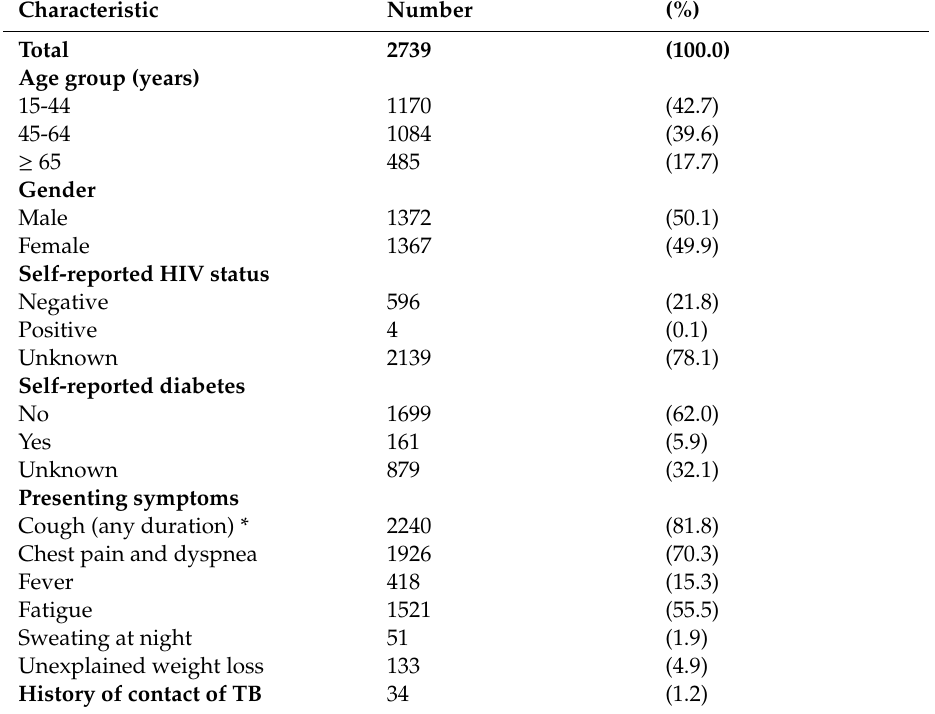
Table 1. Socio-demographic and clinical profile of people with tuberculosis (TB) symptoms or contact history attending the Haiphong International General Hospital in Vietnam, from June to December